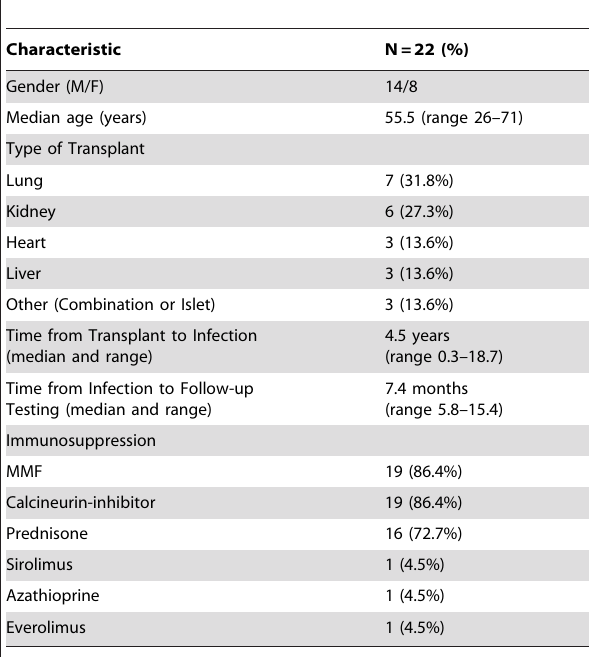
Table 1. Baseline characteristics of cohort with microbiologically proven pandemic influenza A/H1N1 during 2009/2010.